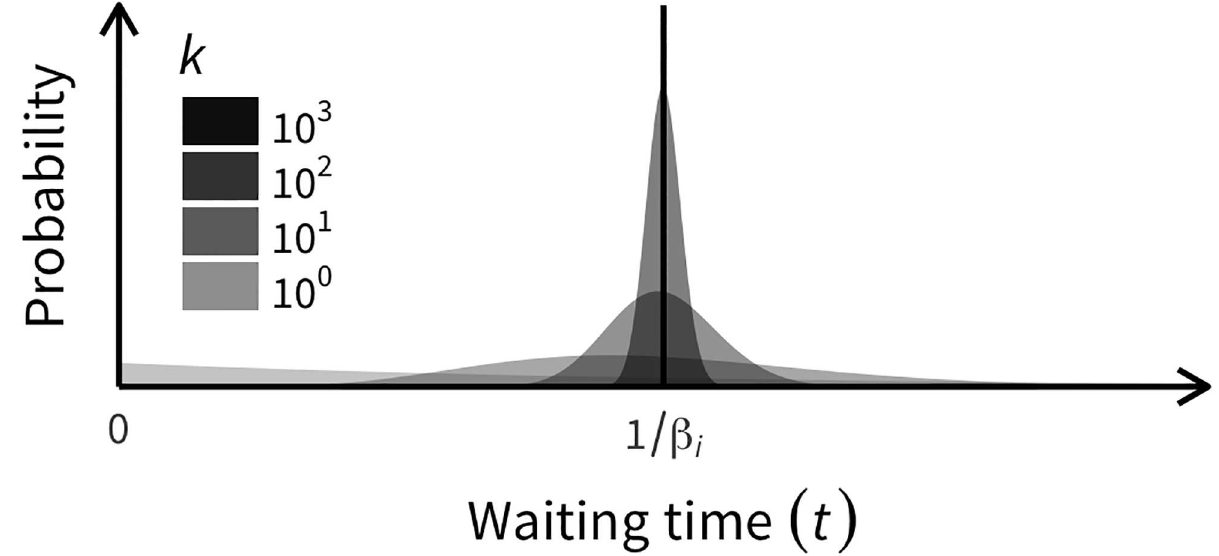
Fig 3. Effect of shape parameter ( k ) on gamma distribution with mean t ¼ 1 is small, t has a wide distribution.In the extreme conditionwhere k = 1, the distribution is identicalto the exponentialdistribution with mean t ¼ 1 b i